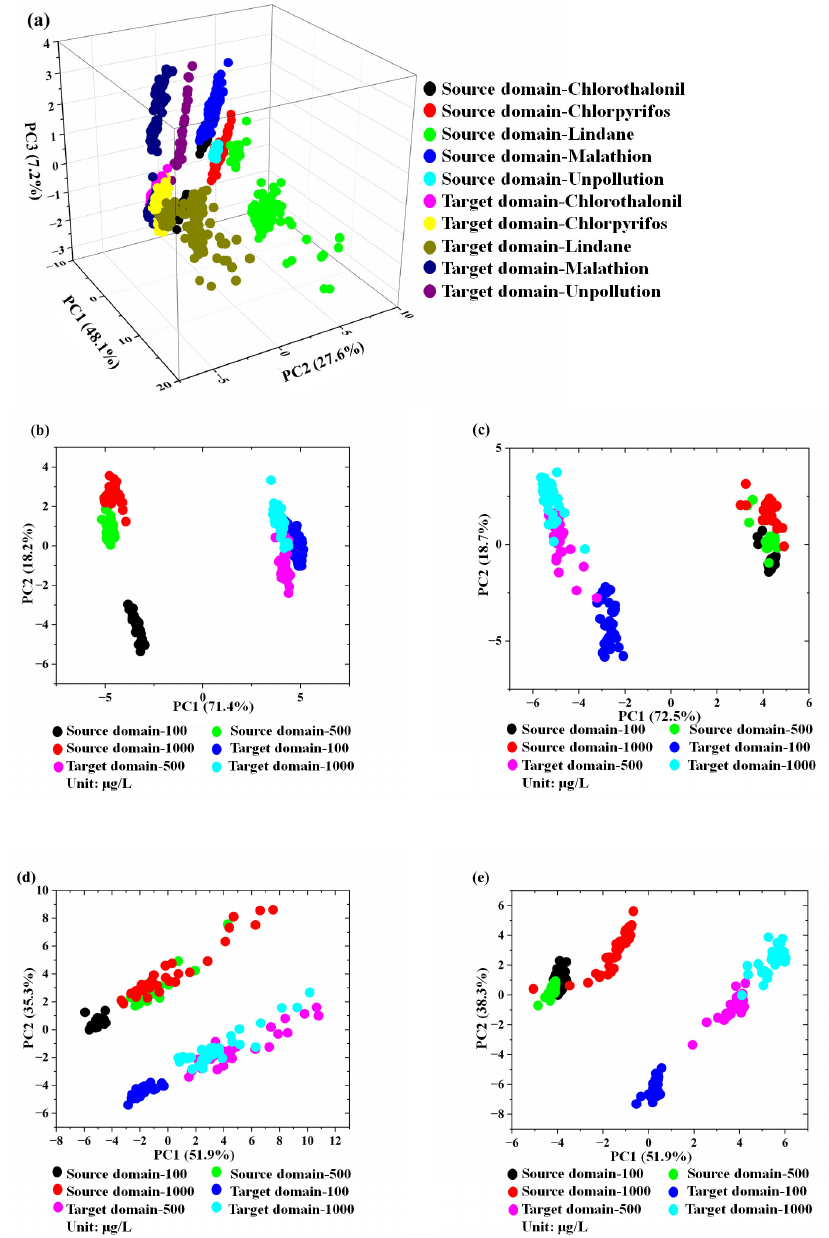
Figure 5. PCA plot performed on source domain and target domain samples. ( a ) qualitative analysis, ( b ) chlorothalonil semi-quantitative analysis, ( c ) chlorpyrifos semi-quantitative analysis, ( d ) lindane semi-quantitative analysis, ( e ) malathion semi-quantitative analysis.